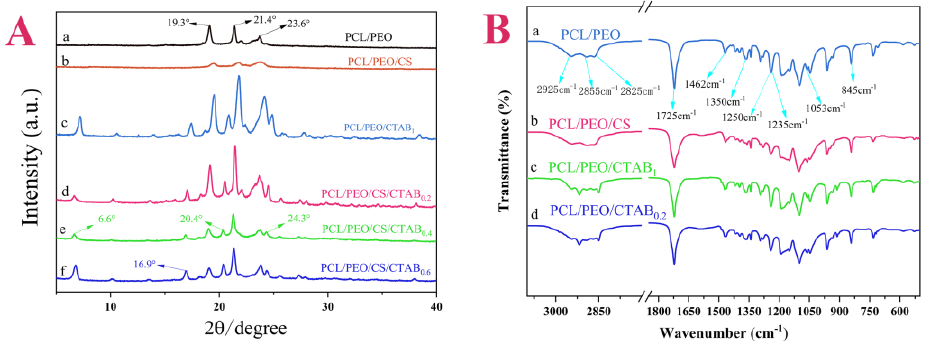
Figure 3. ( A ), XRD patterns of composite spinning films; ( B ), FT-IR spectra of composite spinning